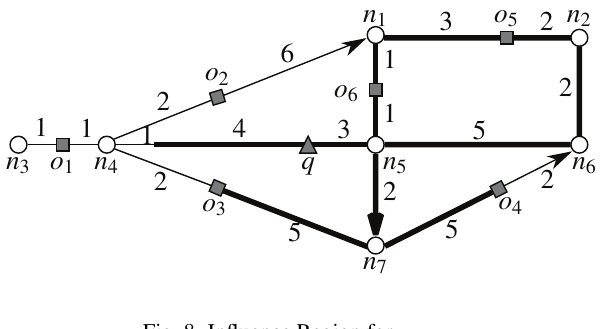
Fig. 7. CalcInfluence